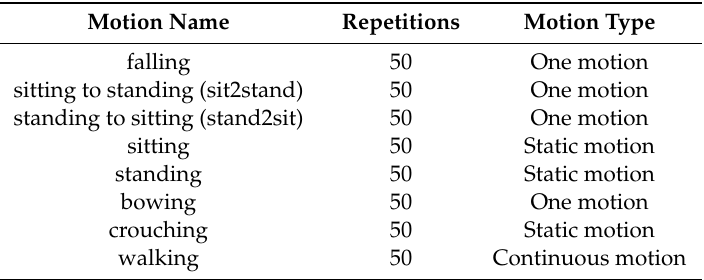
Table 2. Target motions in the motion detection